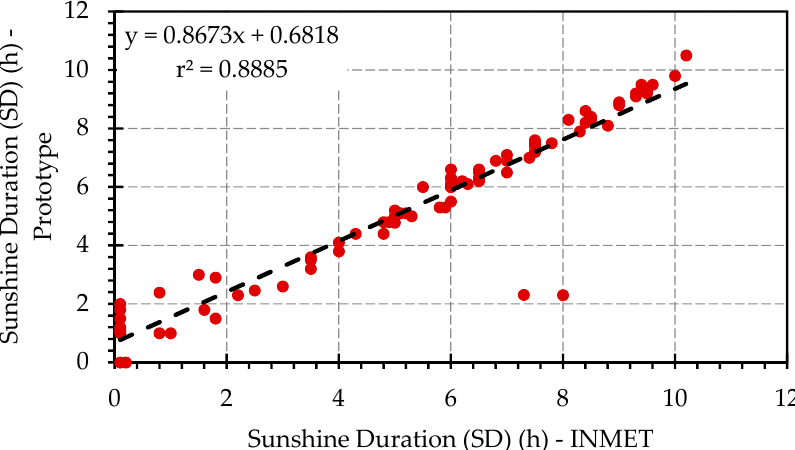
Figure 15. Relationship between sunshine duration (SD) measured with the proposed system and o ffi cial data by the Brazilian National Meteorological Institute (INMET) for the city of Campina Grande, Brazil.